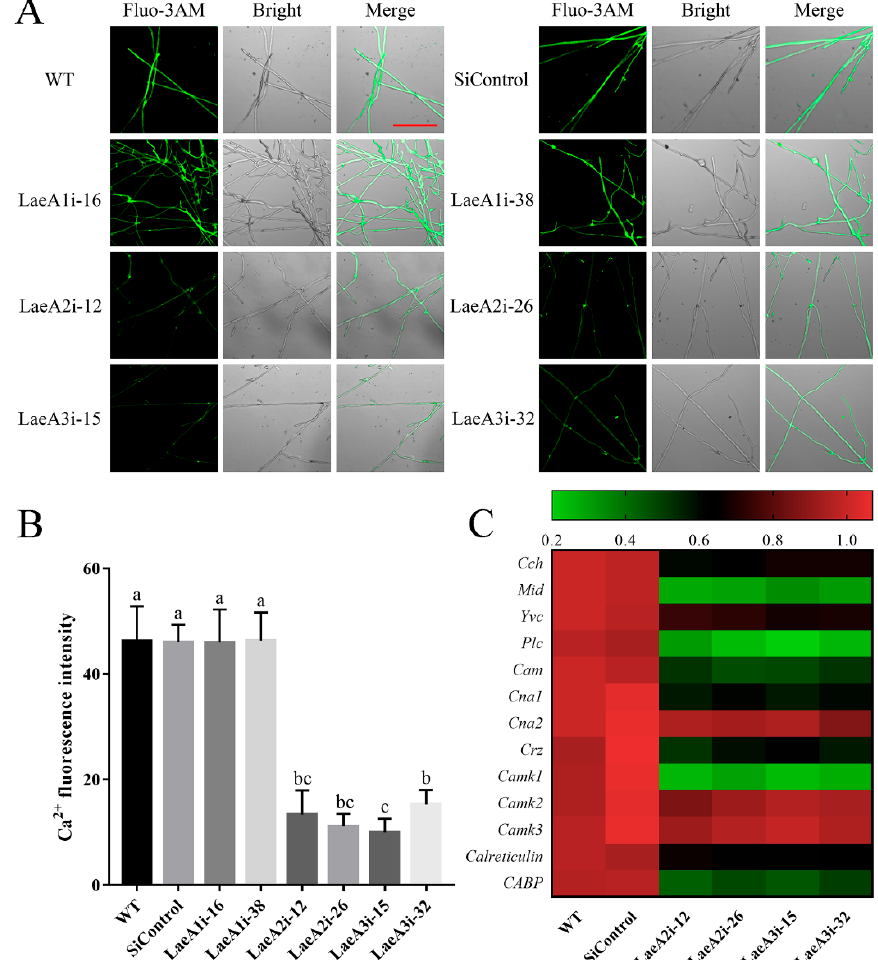
Figure 6. The cytosolic Ca 2+ content in the PoLaeA -silenced strains. The fungal strains were cultured on CYM plates at 28 °C for 4 days. ( A ) Fluo-3AM staining (scale bar = 100 μ m). For detection, 50 μ M Fluo-3AM, a Ca 2+ fluorescent probe, was used to monitor the fluorescence intensity using an LSM780 confocal laser scanning microscope. Green fluorescence represents the free cytosolic Ca 2+ . ( B ) Ca 2+ fluorescence values. The fluorescence was analyzed with ZEN 3.3 (blue edition). ( C ) Transcriptional analysis of Ca 2+ -related genes. The expression levels of the Ca 2+ -related genes in the WT strain were arbitrarily set to 1.0. The values are the mean ± SD ( n = 3). Different lowercase letters indicate significant differences between the strains ( p < 0.05, according to Dunnett’s multiple comparisons test).